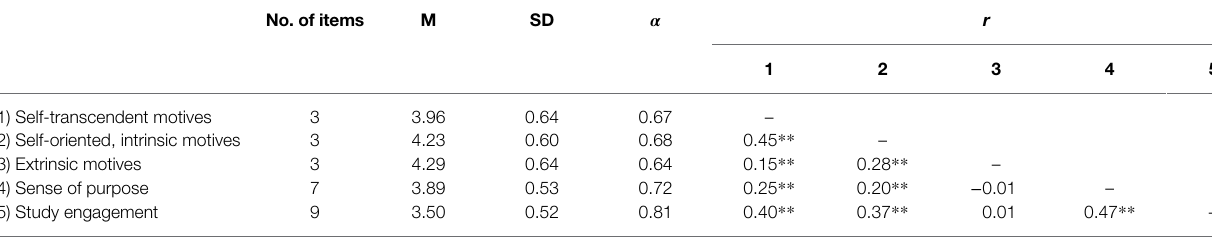
TABLE 1 | Descriptive statistics, Cronbach’s alpha coefficients, and intercorrelations. No. of items